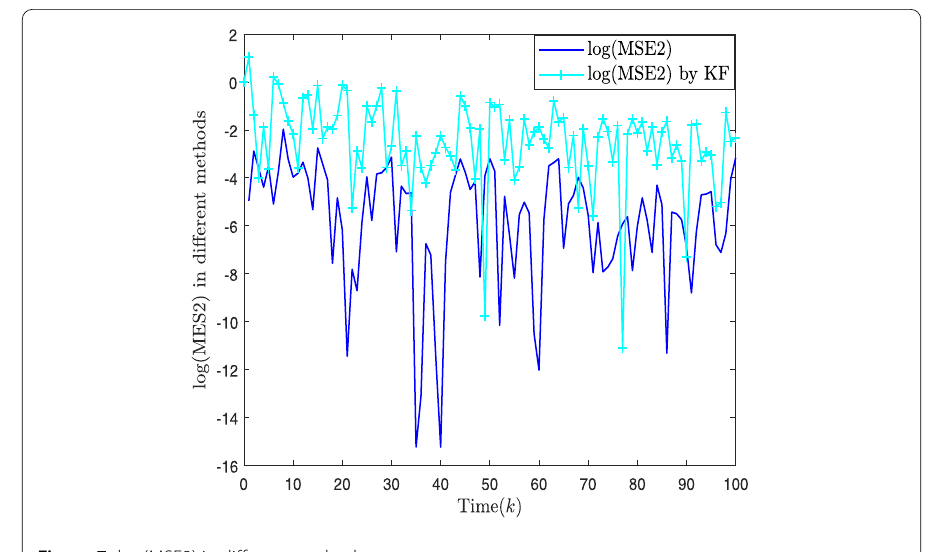
Figure 7 log(MSE2) in different methods